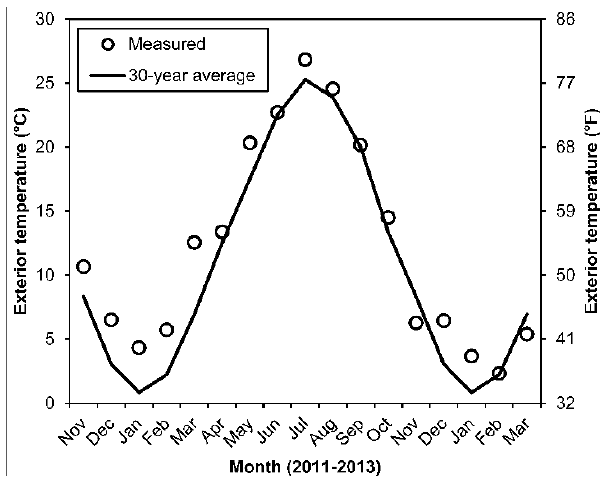
Figure 3. Monthly average exterior temperature measured onsite compared with 30-year average values.